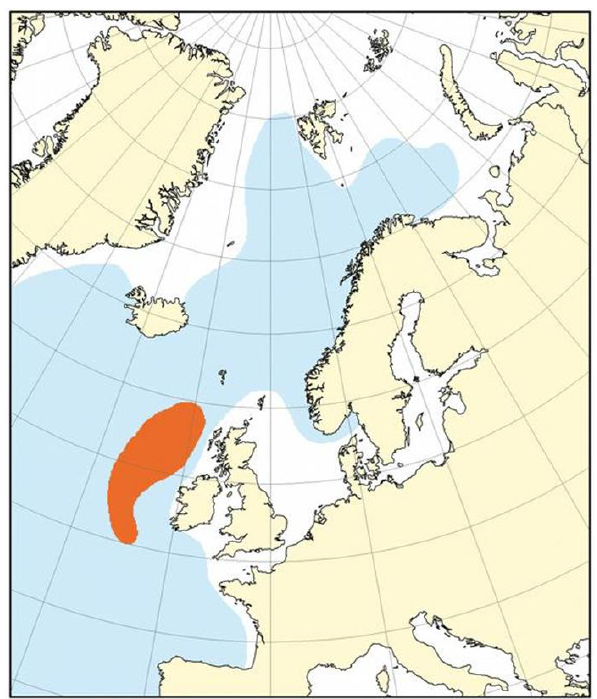
Figure 2. Schematic overview of overall distribution (blue) and spawning area (orange) for blue